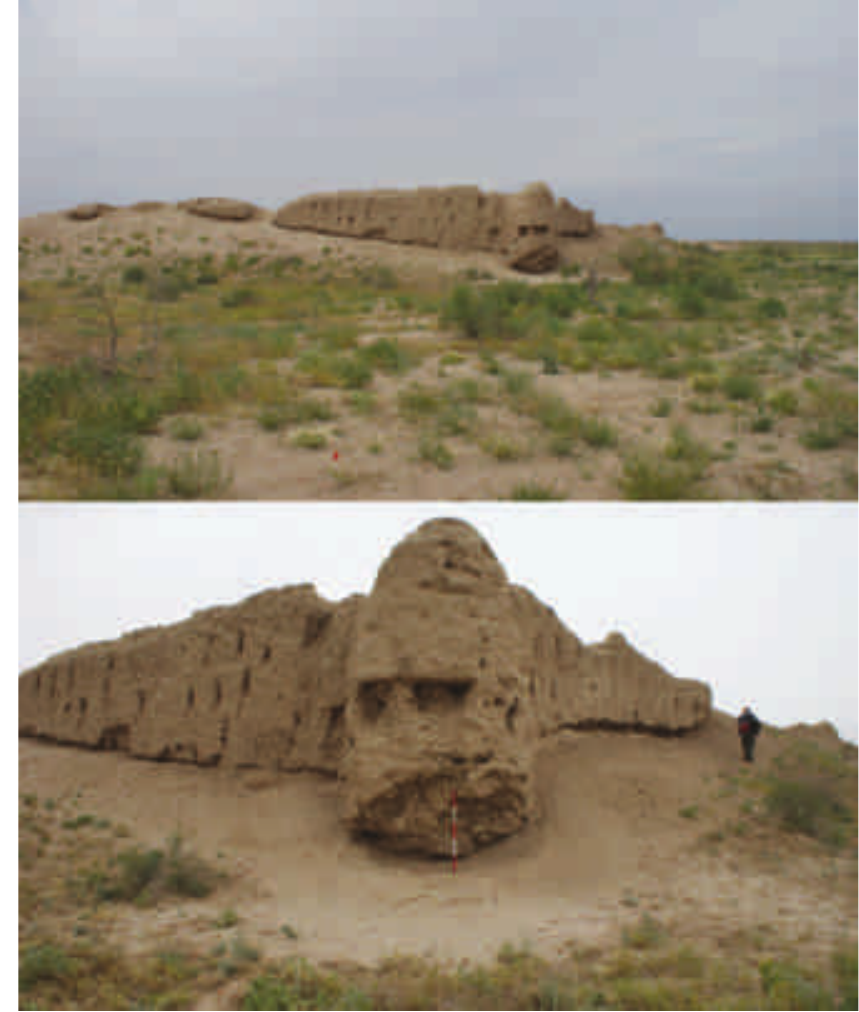
Figure 5 Example of a caravanserai (KRS02-1), close to the modern settlement of